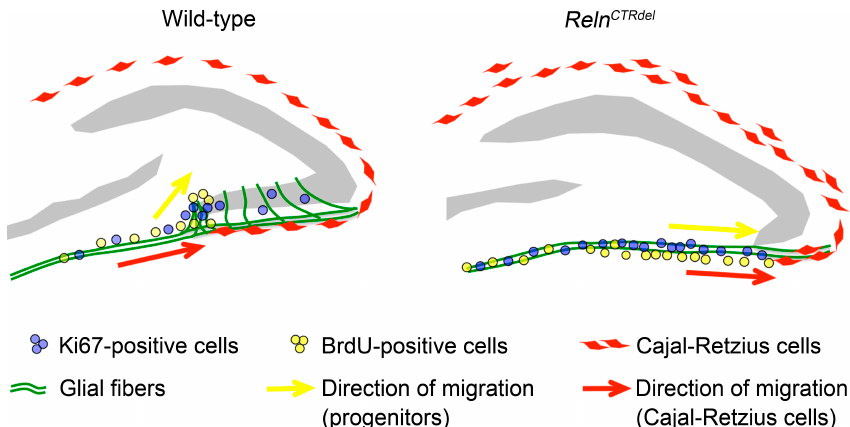
Figure 6. A model of the infrapyramidal malformation. During the first postnatal week, Cajal-Retzius cells disperse along the subpial surface of the IPB. The progenitors migrate along the dentate migratory stream, then along the densely organized glia scaffold at the fimbriodentate junction, proliferate at the tip and extend the IPB. In Reln CTRdel mutant, Cajal-Retzius cells overmigrate to the SPB and are absent in the subpial surface of the IPB. Without proper RELN signal, the glia scaffolds cannot become organized at the fimbriodentate junction, the progenitor cells fail to migrate toward the hilus, and proliferate within the subpial surface. The mutant dentate gyrus fails to form the outer shell in the IPB, which affects subsequent neurogenesis events in the dentate gyrus. In Reln CTRdel mutant, Cajal-Retzius cells fail to settle in the IPB subpial surface, the glial scaffold at the fimbriodentate junction is not organized, this prevent transhilar migration of progenitors, and